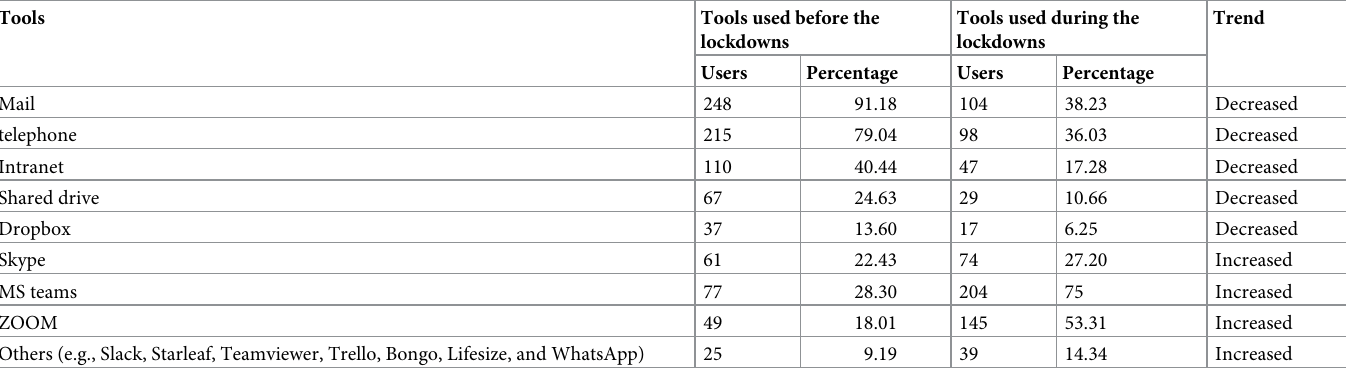
Table 5. Communication tools before and during lockdowns (N =